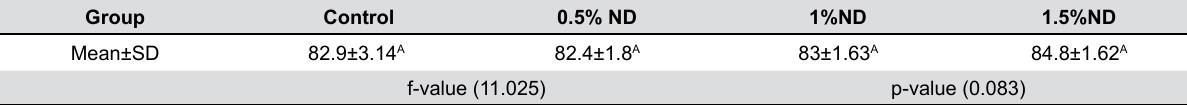
Table 2- Mean and standard deviations of contact angles in all tested groups